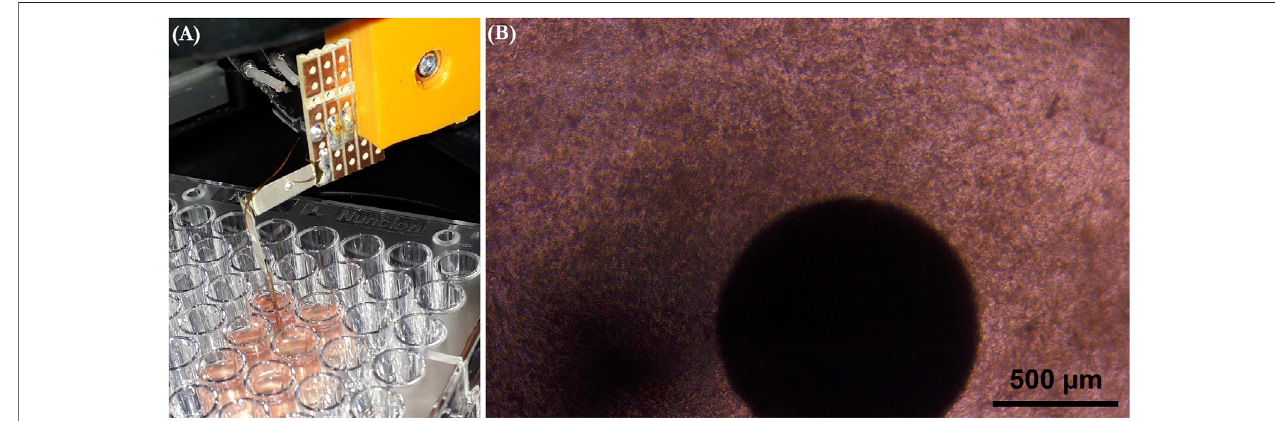
FIGURE 2 | (A) Measurement setup where the culture plate is placed on a heater plate under a microscope, and the measurement sensor is brought into contact with a cardiac tissue construct. (B) Microscope view of the sensor tip attached onto the cardiac tissue construct.